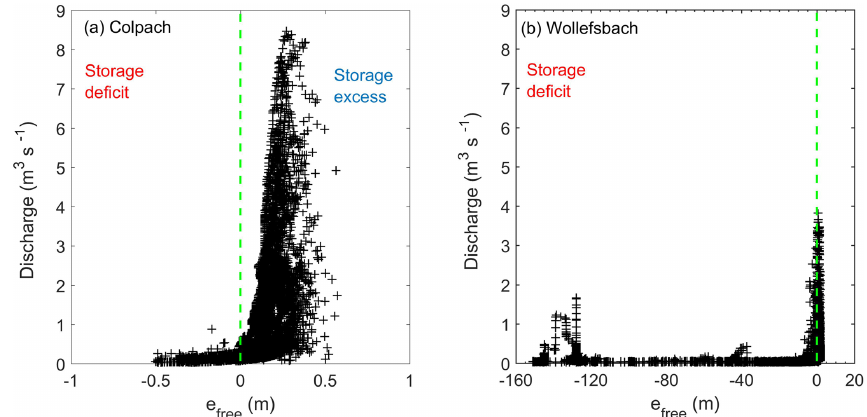
Figure 8. Observed streamflow in the Colpach ( a , drainage area is 19.2km 2 ) and the Wollefsbach ( b , drainage area is 4.5km 2 ) plotted against the free energy of sites in their corresponding riparian